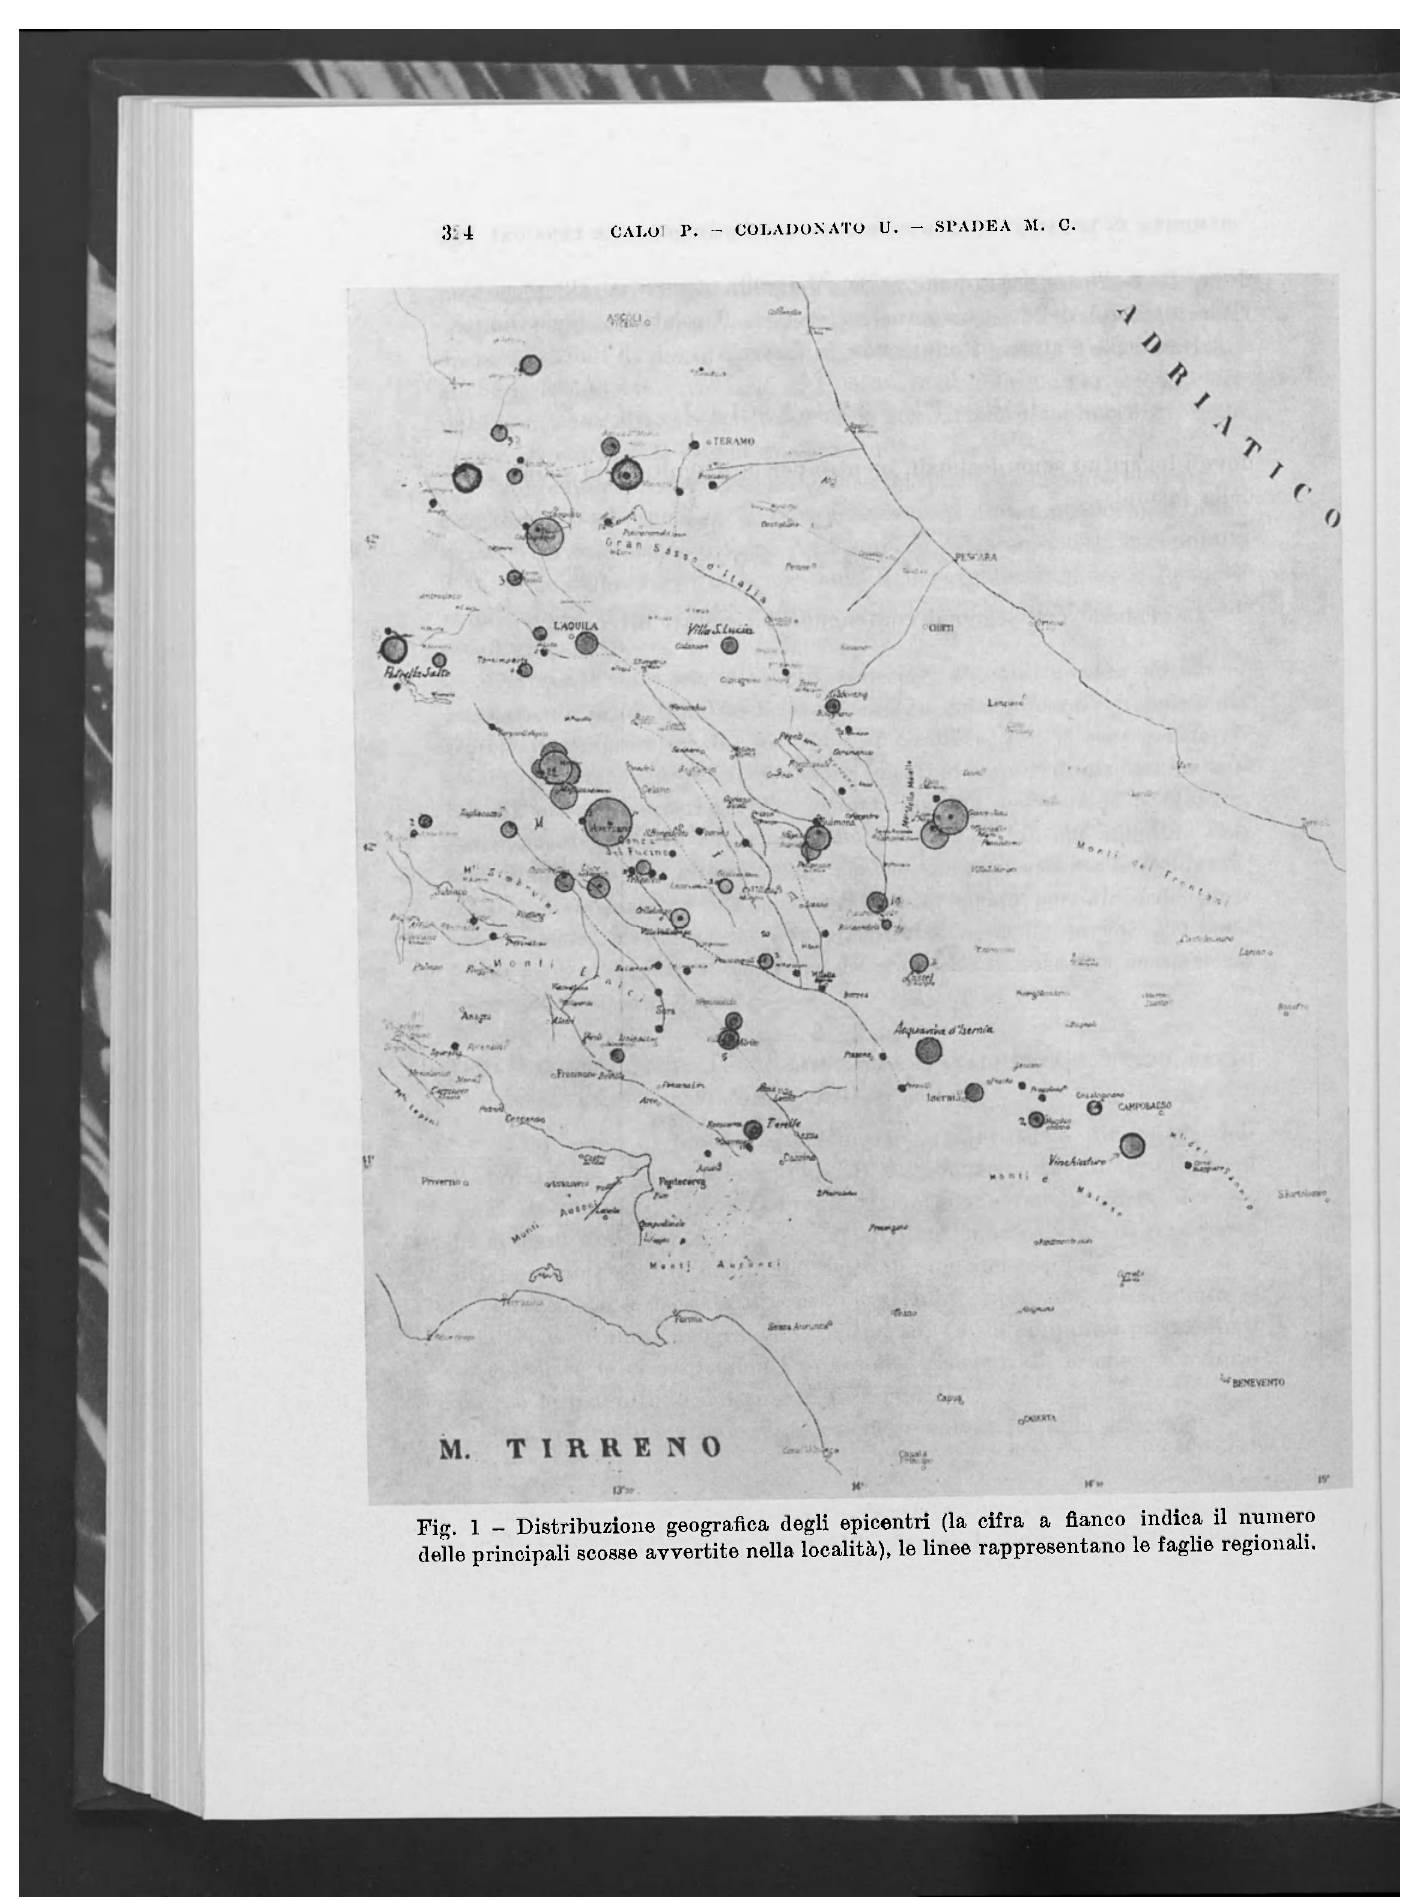
Fig. 1 - Distribuzione geografica degli epicentri (la cifra a fianco indica il numero delle principali scosse avvertite nella località), le linee rappresentano le faglie